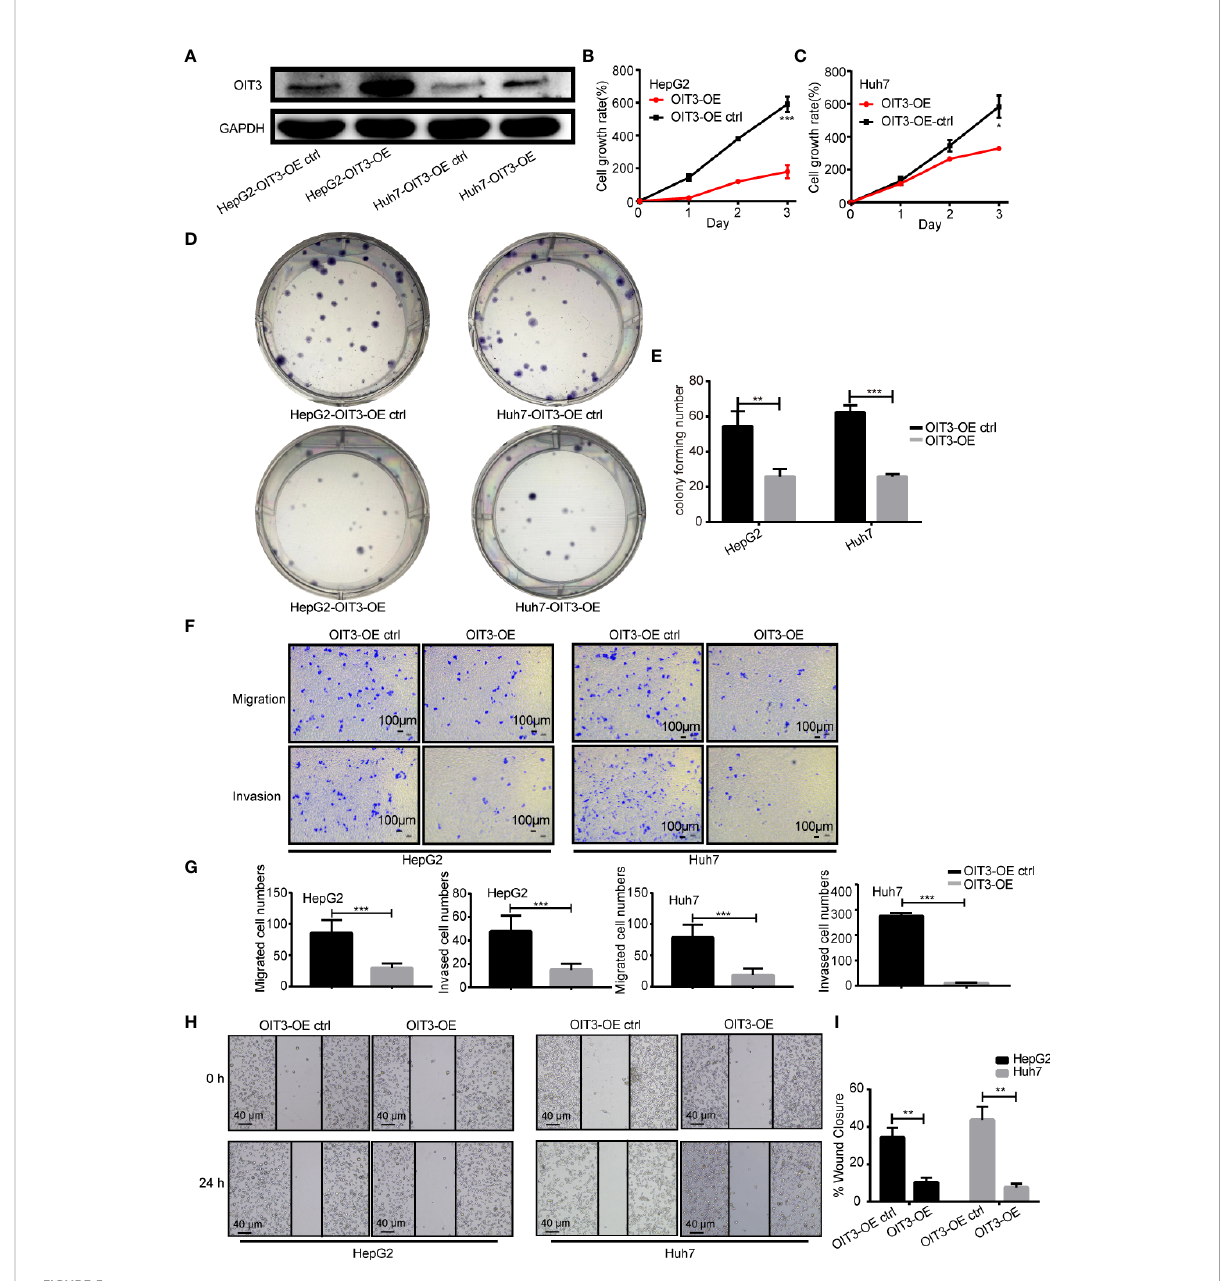
FIGURE 5 OIT3 suppressed the proliferation, clone formation, migration, and invasion abilities of HCC cells in vitro . (A) OIT3 protein level could be increased by OIT3-overexpressed lentivirus vector in HepG2 and Huh7 cells. (B, C) The overexpression of OIT3 could inhibit the proliferation abilities of HepG2 and Huh7 cells. ( *P < 0.05 , ***P < 0.001 ). (D, E) OIT3 upregulation could decrease the clone formation abilities of HepG2 and Huh7 cells. ( *P < 0.05 , **P < 0.01 ). (F, G) OIT3 upregulation could suppress the migration and invasion abilities of HepG2 and Huh7 cells. ( ***P < 0.001 ). (H, I) The effects of OIT3 expression on migration abilities of HepG2 and Huh7 cells were detected with a scratch wound-healing assay. OIT3 ’ s overexpression showed inhibited wound closure levels of 10.3 ± 2.5% in HepG2 cells and 7.7 ± 2.1% in Huh7 cells compared with the control groups respectively (49.7 ± 4.5% in HepG2 cells and 22.7 ± 2.5% in Huh7 cells) for 48 h. Experiments were repeated three times, and the data are expressed as the mean ± SEM. OIT3-OE, OIT3-overexpressed lentivirus vector; OIT3-OE ctrl, OIT3-overexpressed lentivirus vector